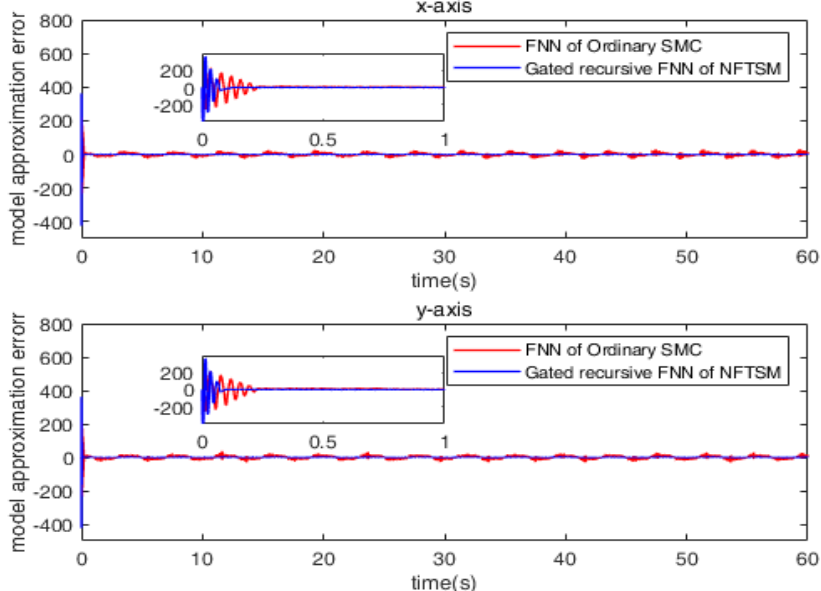
Figure 14. Comparison of the approximation performance between NFTSMC ‐ GRFNN and SMC ‐ FNN.